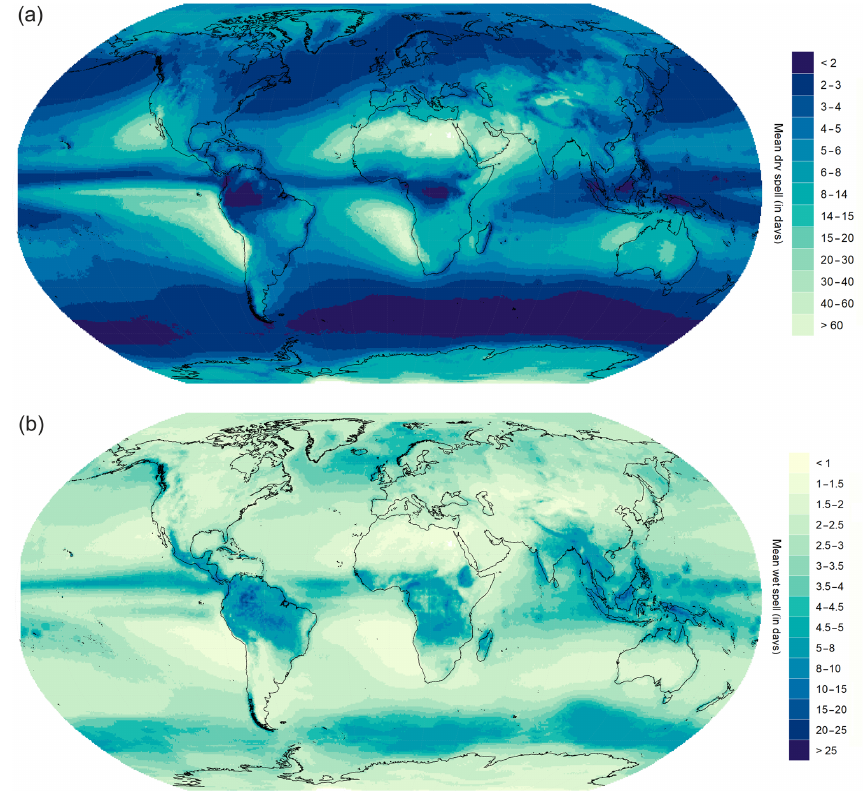
Figure A1. Spatial distribution of mean dry spell (a) and mean wet spell (b) at a spatial resolution of 0 . 5 ◦ × 0 . 5 ◦ according to the MSWEP dataset (1979–2016).